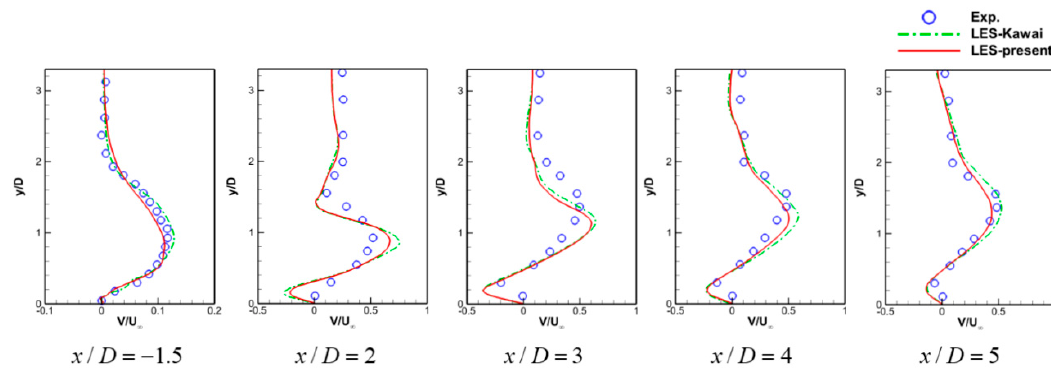
Figure 3. Comparisons of the mean wall-normal velocity V / U ∞ profiles between the LES and the experimental data at x / D = − 1.5, 2, 3, 4, and 5; solid lines: Present LES, dotted line: Kawai’s LES, circle symbols: Experimental.